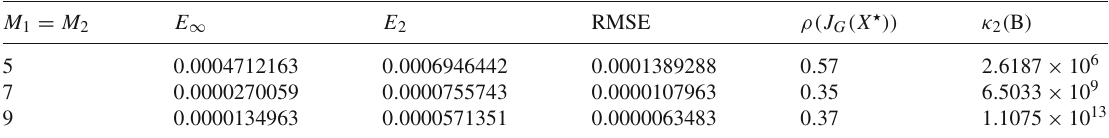
Table 10 The errors and ρ( J G ( X (cid:8) )) and condition number of B resulted by IQ-RBFs with c = 1 . 95 for τ = 0 . 02, α = 0 . 35, , a ] = [ b , b ] = [− 1 , 1 ] and t = 1 in Example [ a 1 2 1 2